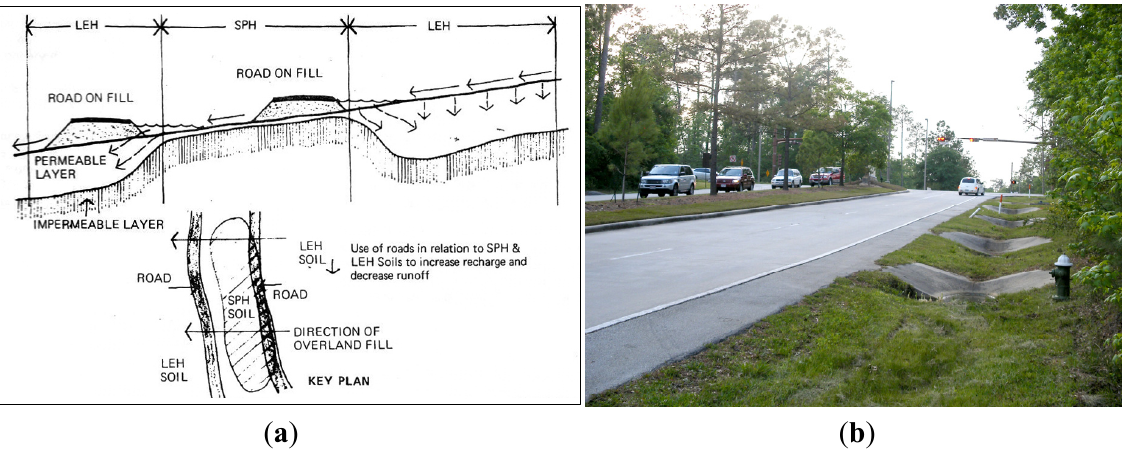
surface drainage along collector streets in The Woodlands.